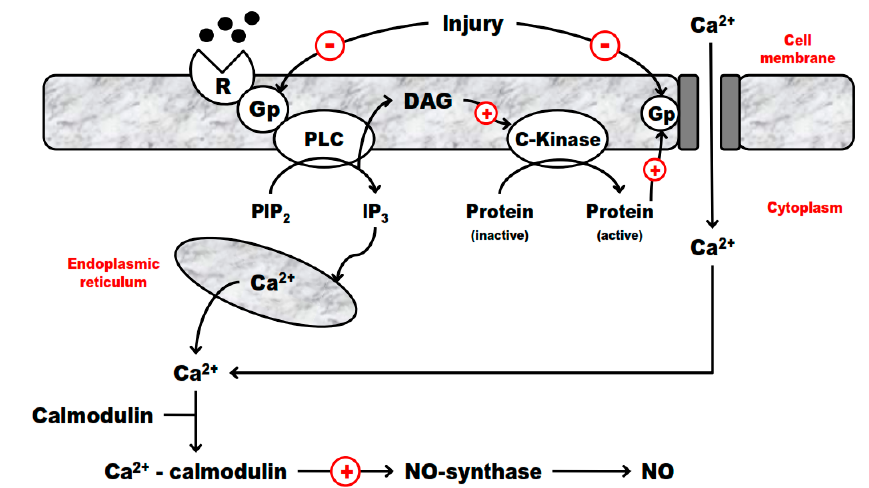
Figure 1. Proposed mechanism of impaired endothelium-dependent vasodilation after coronary reperfusion injury. Upon reperfusion, free radicals from a variety of sources induce injury to G-proteins (Gp) that link intracellular processes. Two possible sites of injury in the present model are the signal transduction pathway between the cell receptor (R) and phospholipase C (PLC) and the pathway that activates the influx of extracellular calcium for sustained production of endothelium-derived nitric oxide (NO). (DAG = diacylglycerol, IP 3 = inositol trisphosphate, PIP 2 = phosphatidylinositol 4,5-biphosphate, ( − ) = inhibits, (+) = stimulates.) (Adapted from Evora et al. [4]).